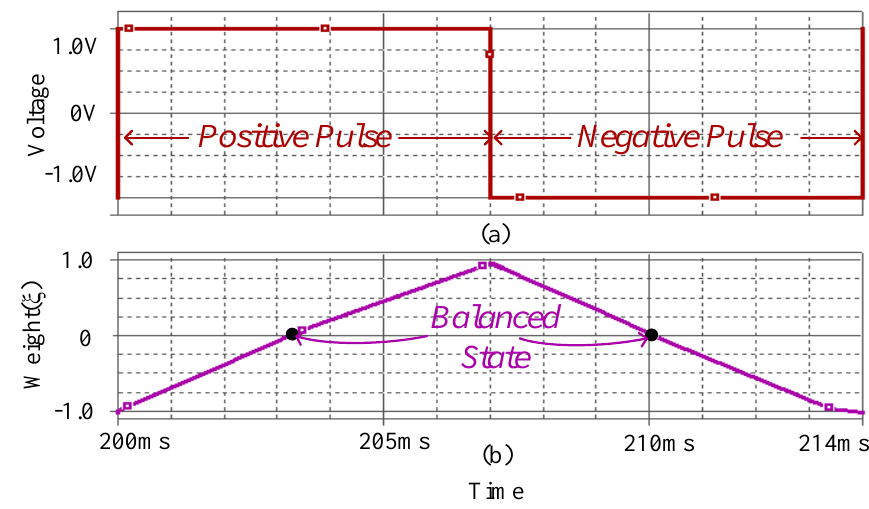
Figure 10. Weight variations of the memristor bridge circuit while positive and negative pulses are applied ( a ) positive and negative input pulses; ( b ) weight variations during each pulse period.